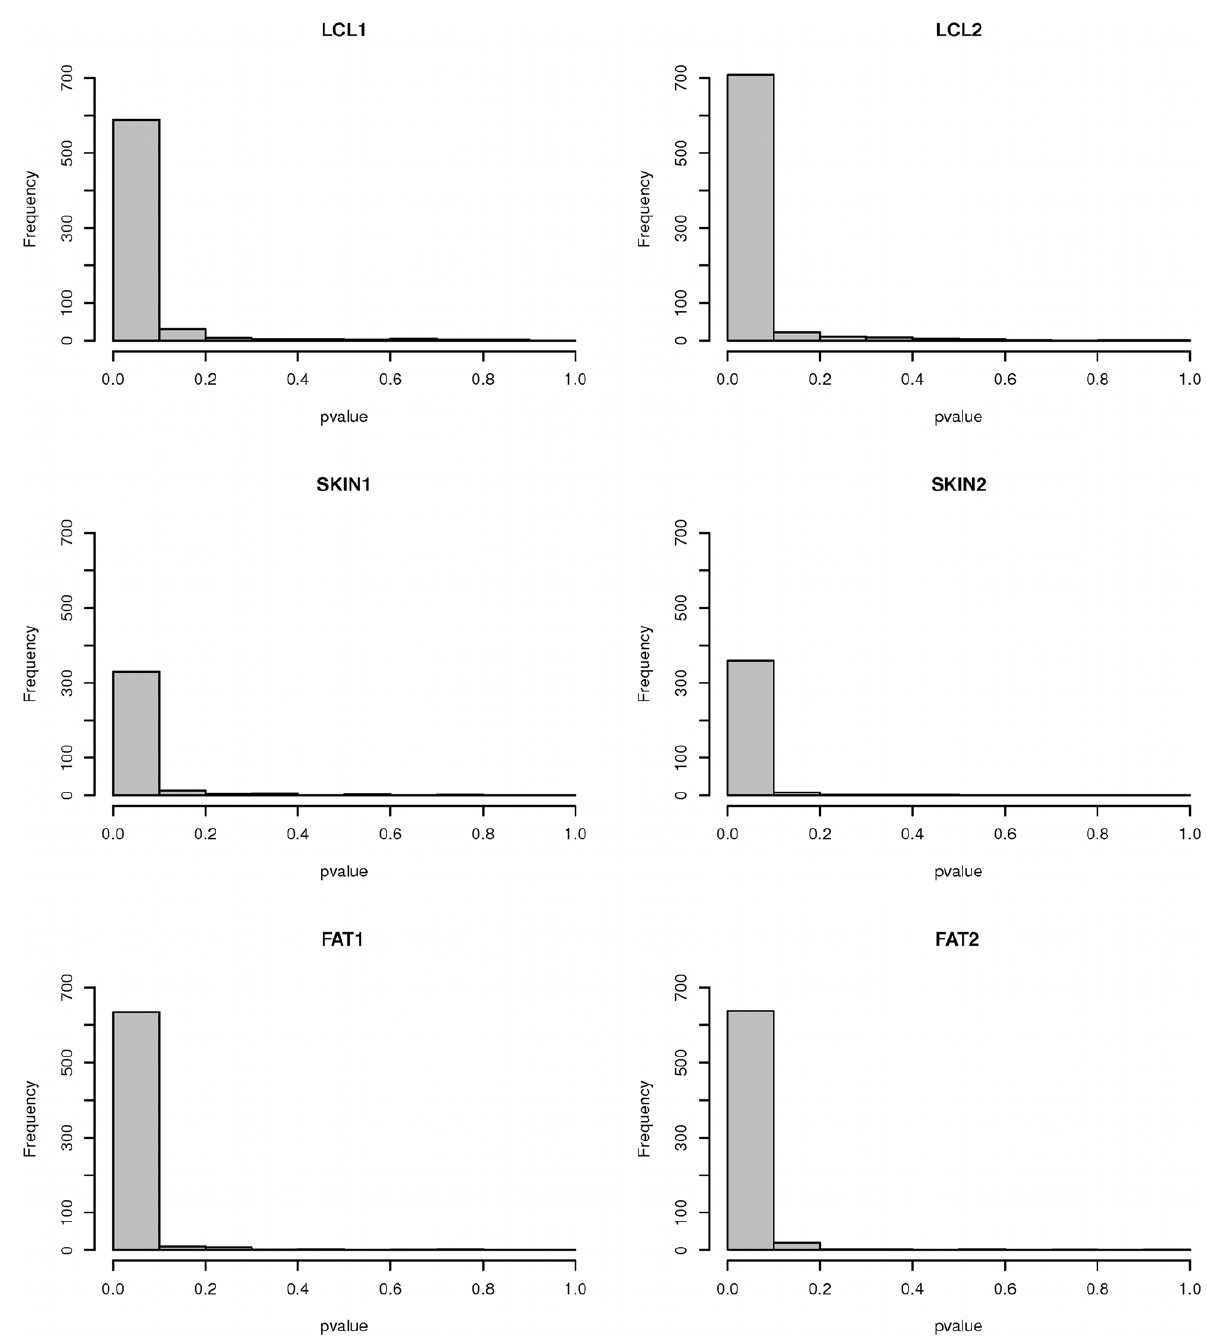
Figure 1. P-value distribution of cis eQTLs (10 2 3 PT) gained with FA correction in the uncorrected data. The significant overrepresentation of low p-values for the new eQTLs ( p 1 =0.99) shows that the signal existed in the uncorrected data but wasn’t called significant due to low power. In each tissue, the exact SNP-gene combinations (eQTLs) tested are presented for both co-twin sets (Twin 1—first column, Twin 2—second